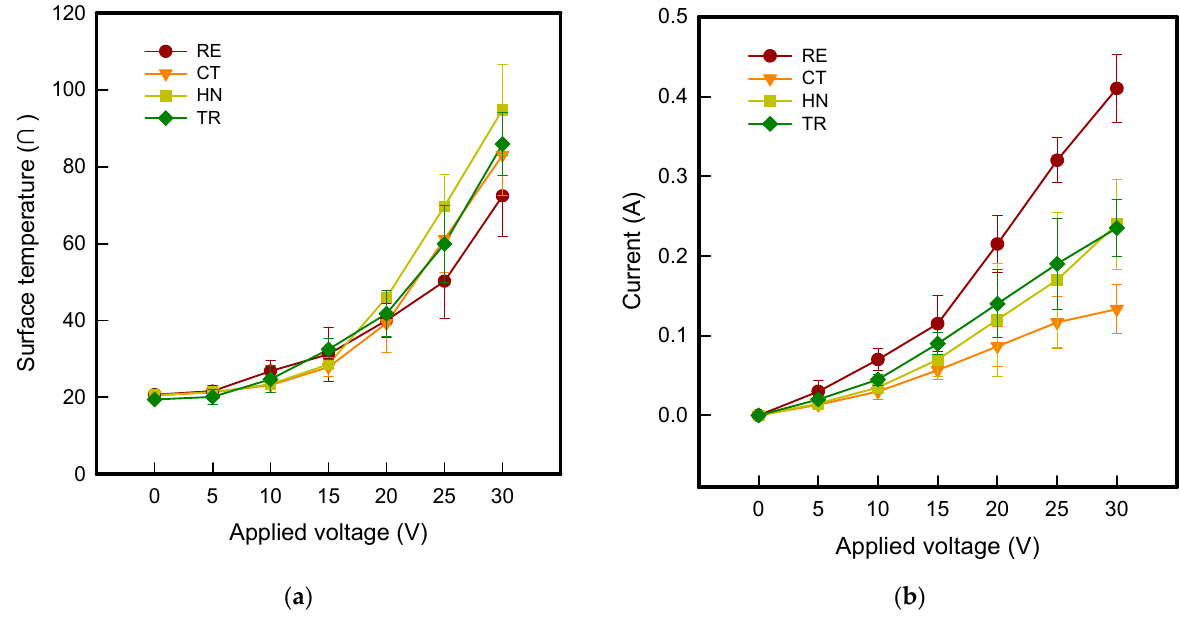
Figure 2. ( a ) Surface temperature and ( b ) I-V curve of 4 types of CFDM 3D printed graphene/PLA auxetic